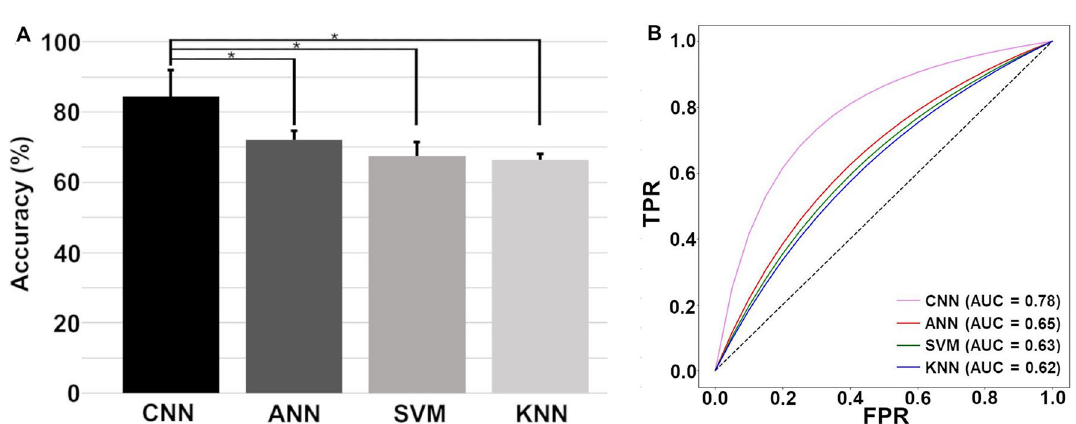
Figure 2. ( A ) Means and standard deviations of the prediction accuracies of each algorithm. Single asterisks (*) indicates a statistically significant difference between the prediction accuracies of different algorithms (CNN > ANN, SVM, and KNN, p < 0.001). ( B ) ROC AUCs (receiver operating characteristic area under curves) of CNN, ANN, SVM, and KNN to predict VTA 60 seconds before the occurrence. TPR: True Positive Rate and FPR: False Positive Rate accuracies.